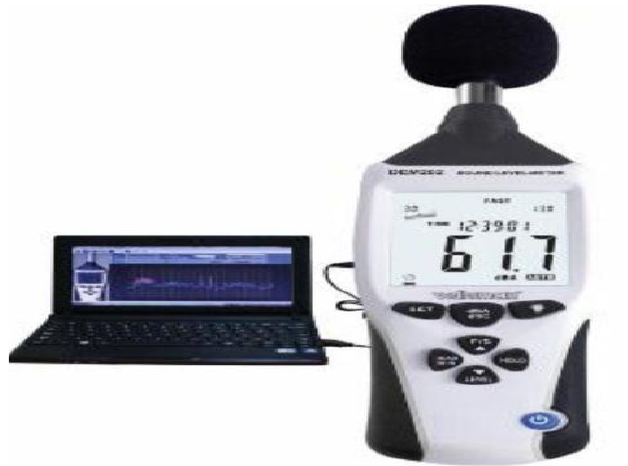
Figure 1. DM202 integrating portable and professional sound level meter by